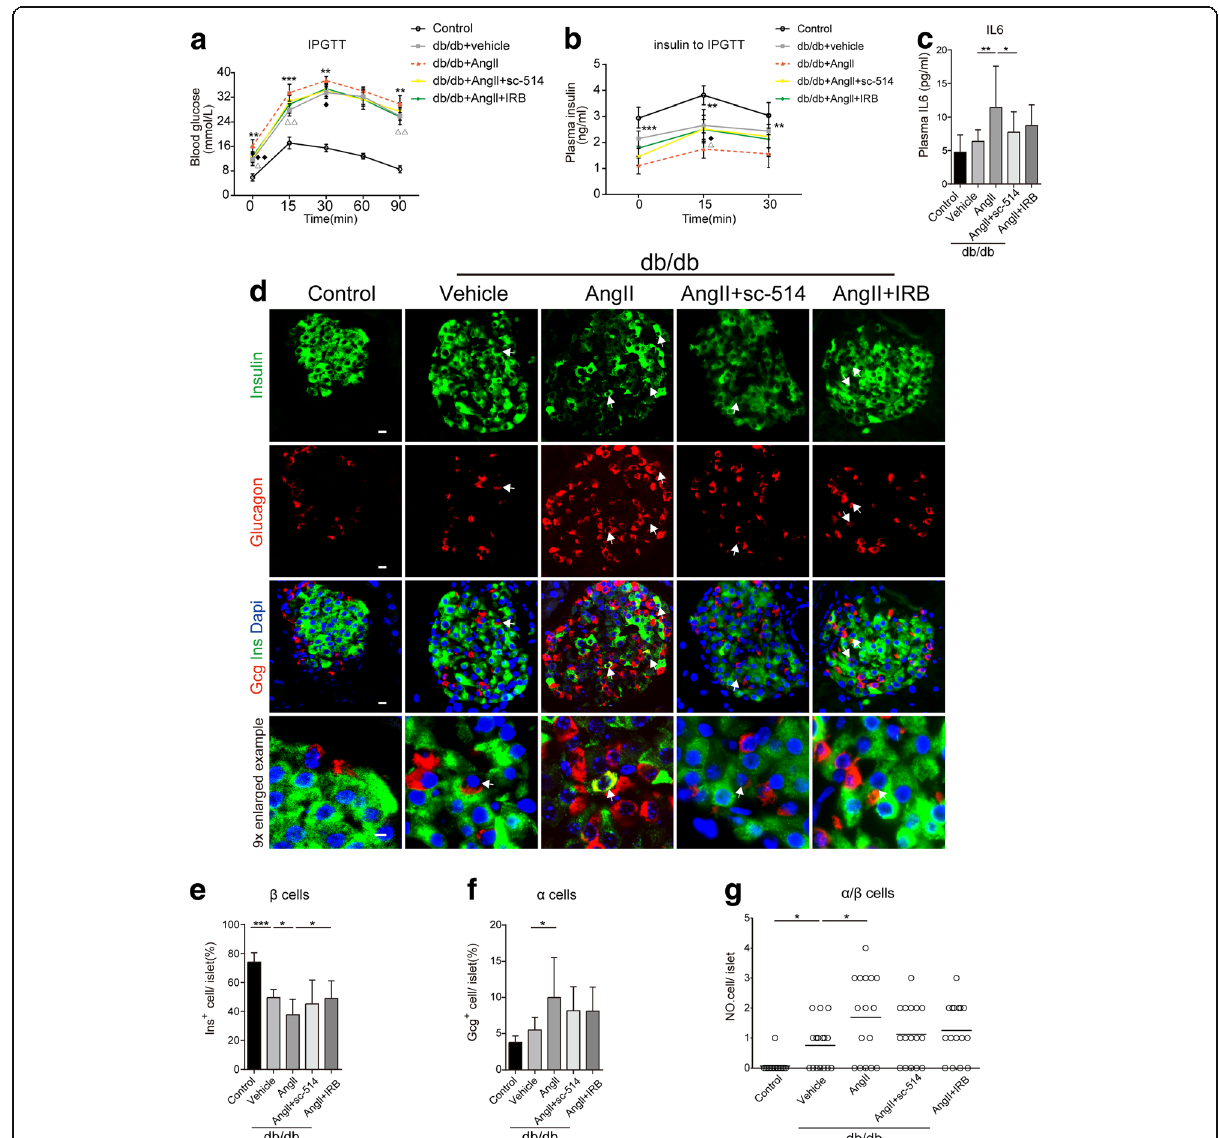
Fig. 4 (color; online only) Angll treatment of diabetic mice potentiates impaired glucose tolerance and compromised β -cell identity. db/db mice were injected with Angll (60 μ g/kg) subcutaneously twice a day for 4 weeks. Where indicated, either sc-514 (30 mg/kg) or Irbesartan (IRB) (50 mg/kg) was also administered. a Glucose levels in homeostasis and intraperitoneal glucose tolerance tests (IPGTTs) for the indicated groups ( n ≥ 6 for each group). b Levels of circulating insulin during IPGTT ( n = 6 for each group). Data ( a, b ) are presented as the mean ± SEM, * p < 0.05, ** p < 0.01, *** p < 0.001 (Angll treated vs. db/db control); ♦ p < 0.05, ♦♦ p < 0.01 (Angll treated vs. sc-514 treated); △ p < 0.05, △△ p < 0.01, (Angll treated vs. IRB treated), as assessed using repeated measures ANOVA ( c ) Plasma IL-6 measurements ( n ≥ 6 for each group). Mean ± SEM,* p < 0.05, ** p < 0.01, *** p < 0.001, one-way ANOVA ( d ) Paraffin embedded sections from the indicated groups were immunolabeled for insulin (green), glucagon (red), and DAPI (blue). Scale bar (10 μ m). Arrow in the 9× enlarged example image indicates a typical insulin + glucagon + (Ins + Gcg+) cell. Scale bar (5 μ m) in the 9× enlarged example image. e, f Quantification of labeled insulin or glucagon positive cells per islet. g Numbers (NO.) of insulin + glucagon + cells. For Immunofluorescence analysis (e-g): n ≥ 4 mice per group, n ≥ 20 islets per marker. Mean ± SEM * p < 0.05, ** p < 0.01, *** p < 0.001, one-way